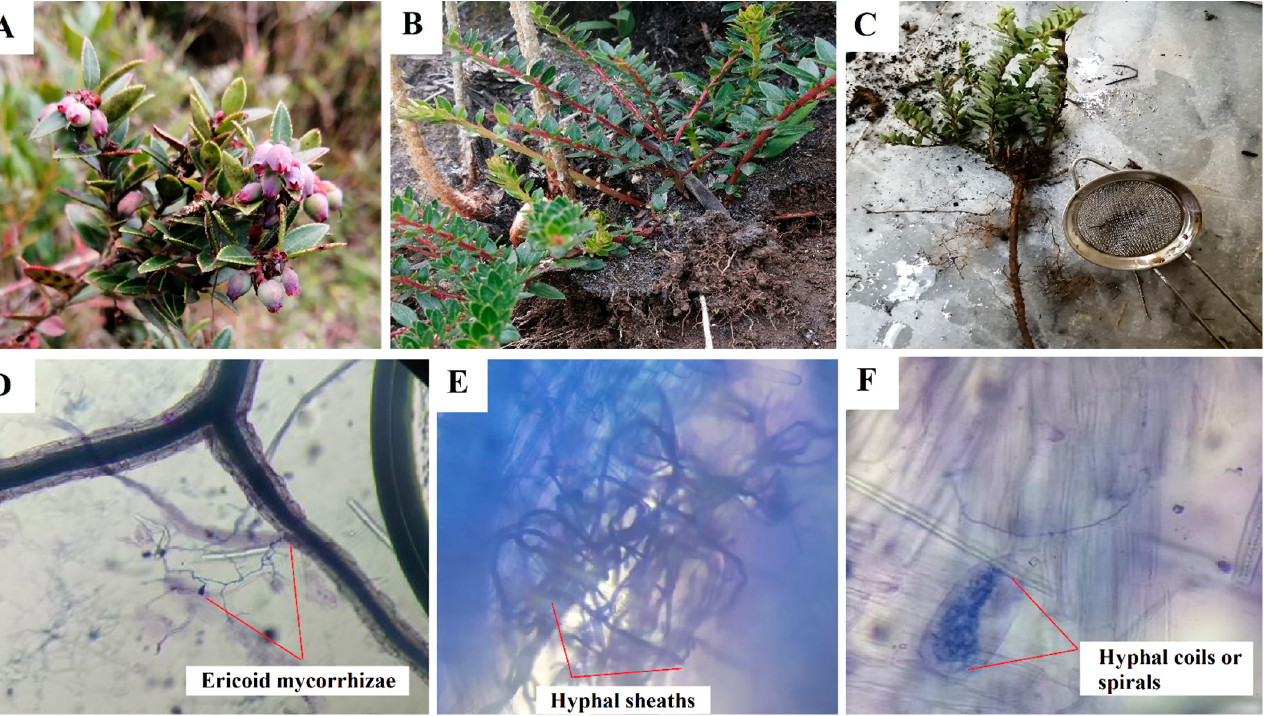
Figure 1. Blueberry plants ( Vaccinium floribundum ); ( A ) immature fruits, ( B ) stems; and ( C ) mortiño roots; ( D ) hyphae extending out of the root; ( E , F ) intracellular structures of ericoid mycorrhizae in stained roots. Pictures: J. Naranjo-Morán and R. Moreira-Gómez.